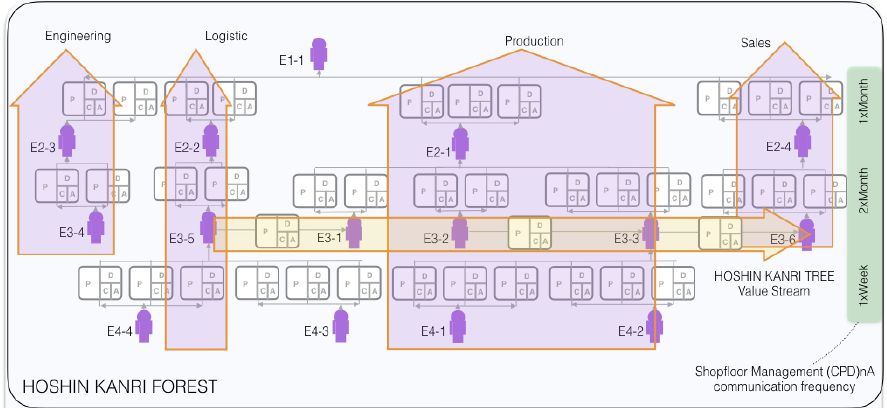
Figure 3. Part of the HOSHIN KANRI FOREST STRUCTURE